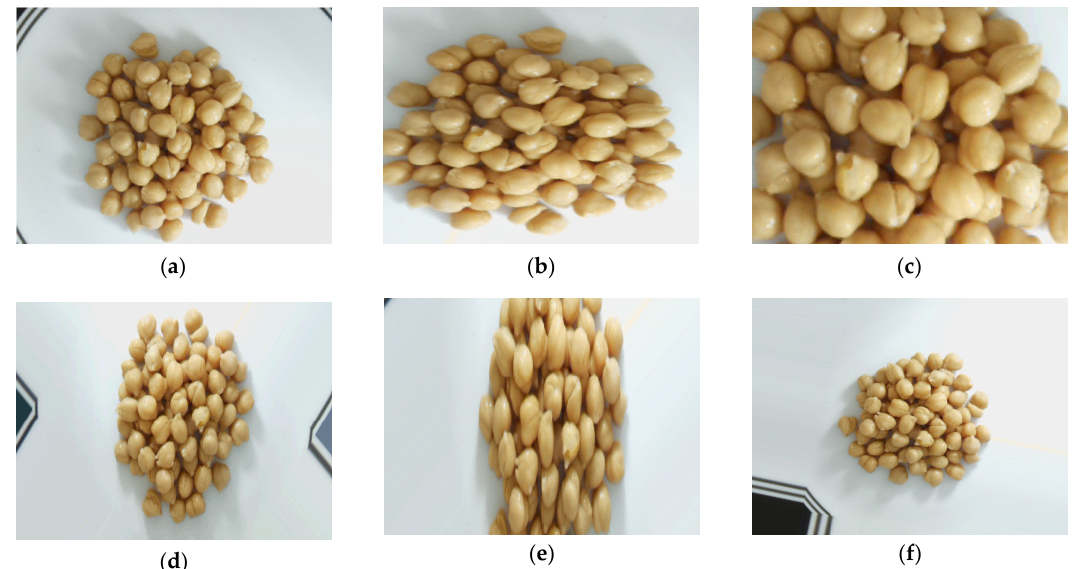
Figure 2. ( a ) original image; ( b )–( f ) augmented images using different transformations.